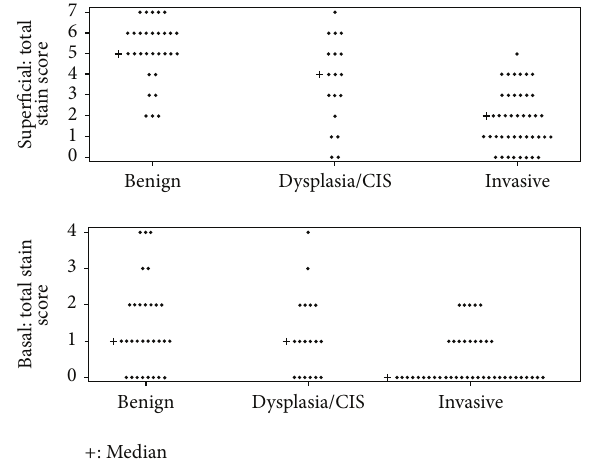
Figure 4: Total stain scores in the superficial cellular compartments and the basal cellular compartments among the tissue categories of benign, dysplasia/carcinoma in situ, and invasive squamous cell car- cinoma. A statistically significant trend is seen in CALML3 expres- sionfrombenignmucosalcellstoinvasivesquamouscellcarcinoma. As disease severity increases, CALML3 expression